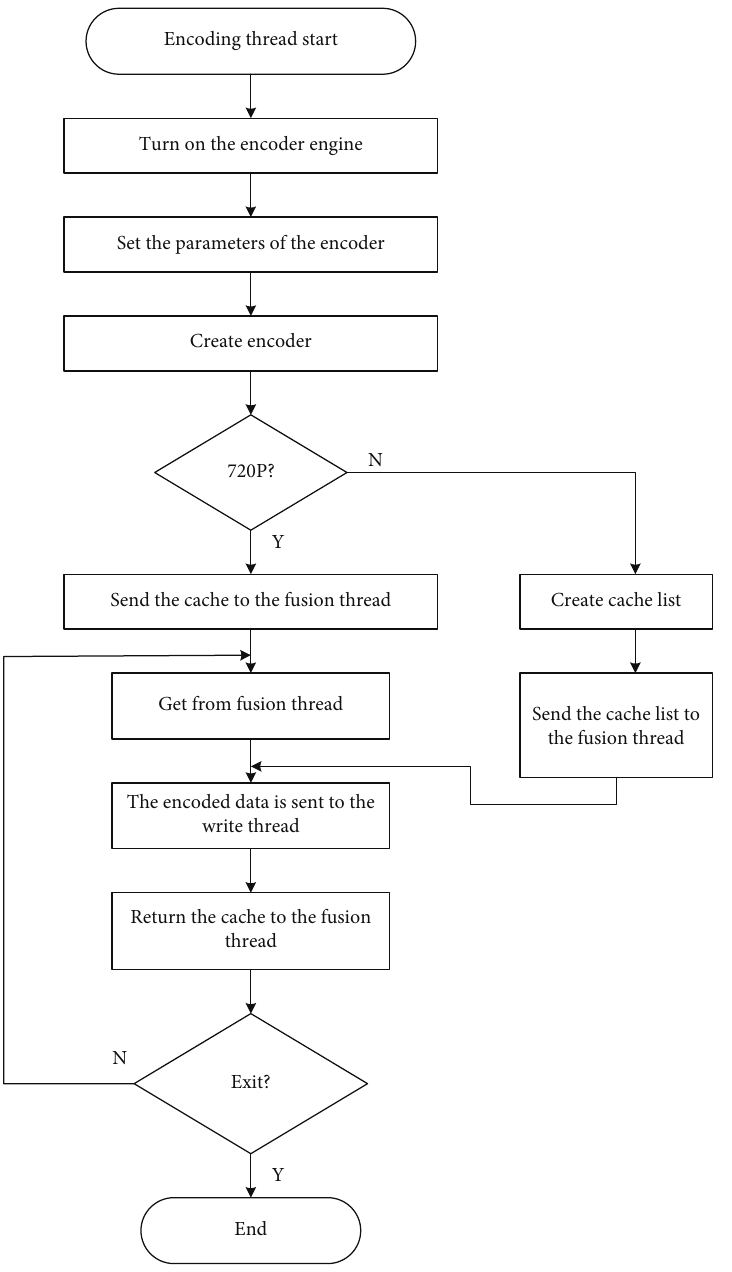
Figure 7: Brief fl ow chart of compression coding